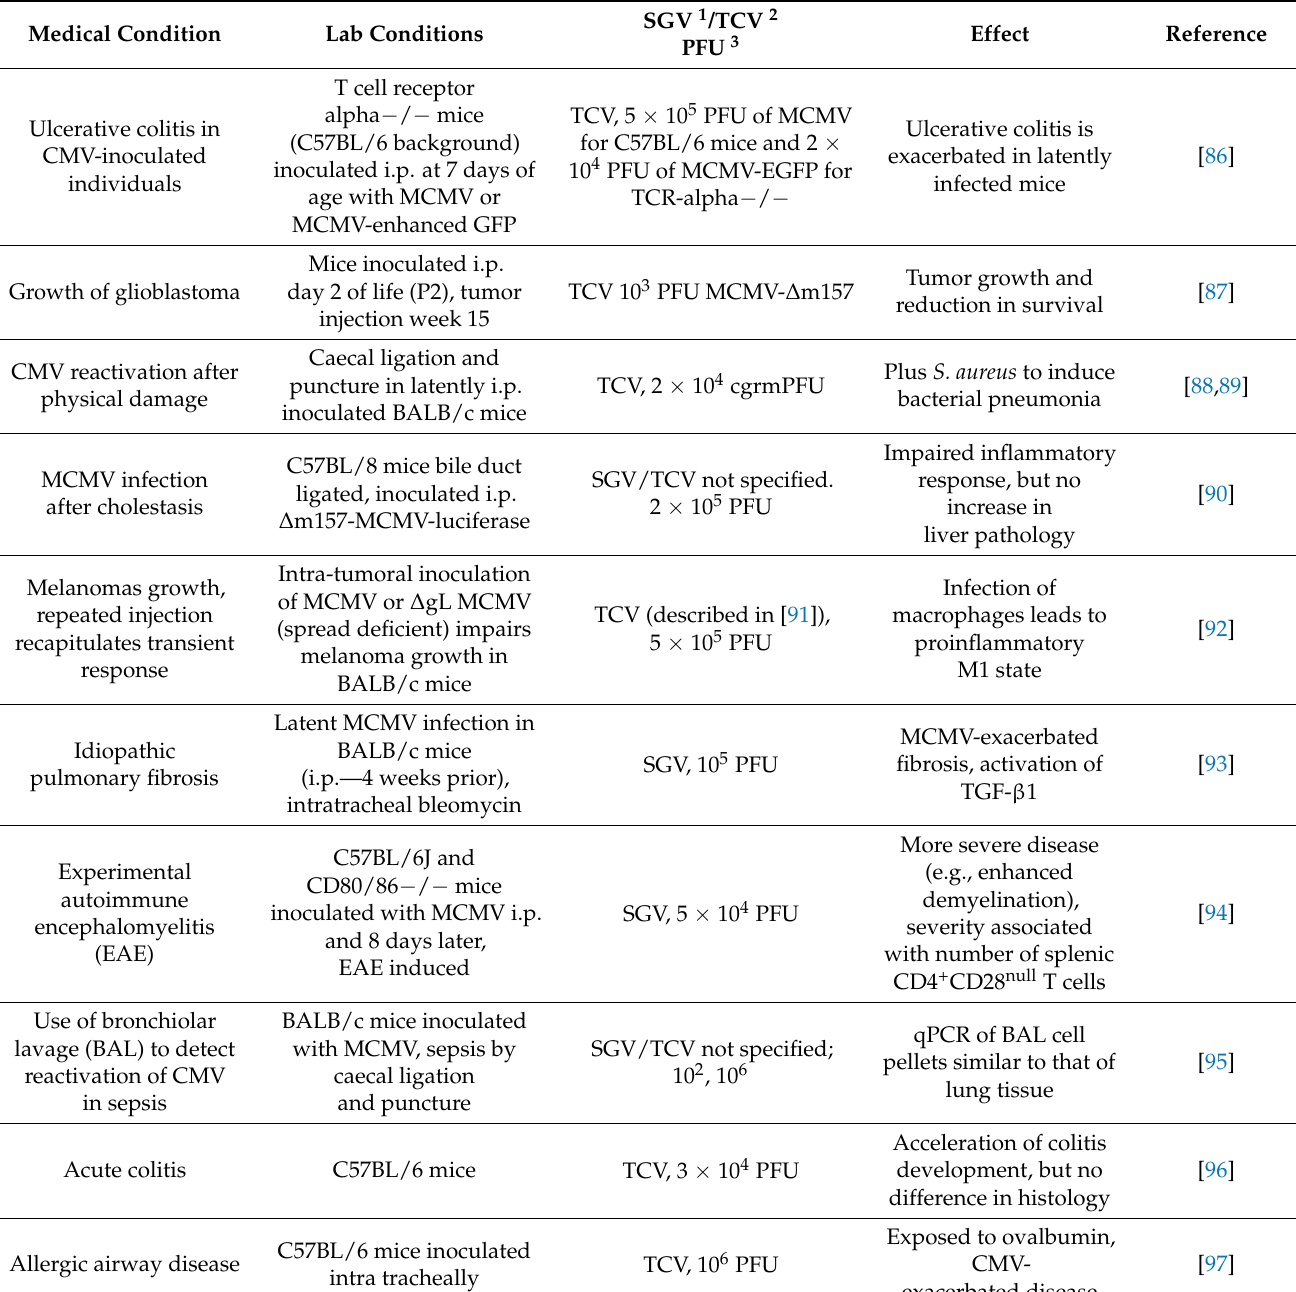
Table 3. Models demonstrating MCMV-associated effects on other